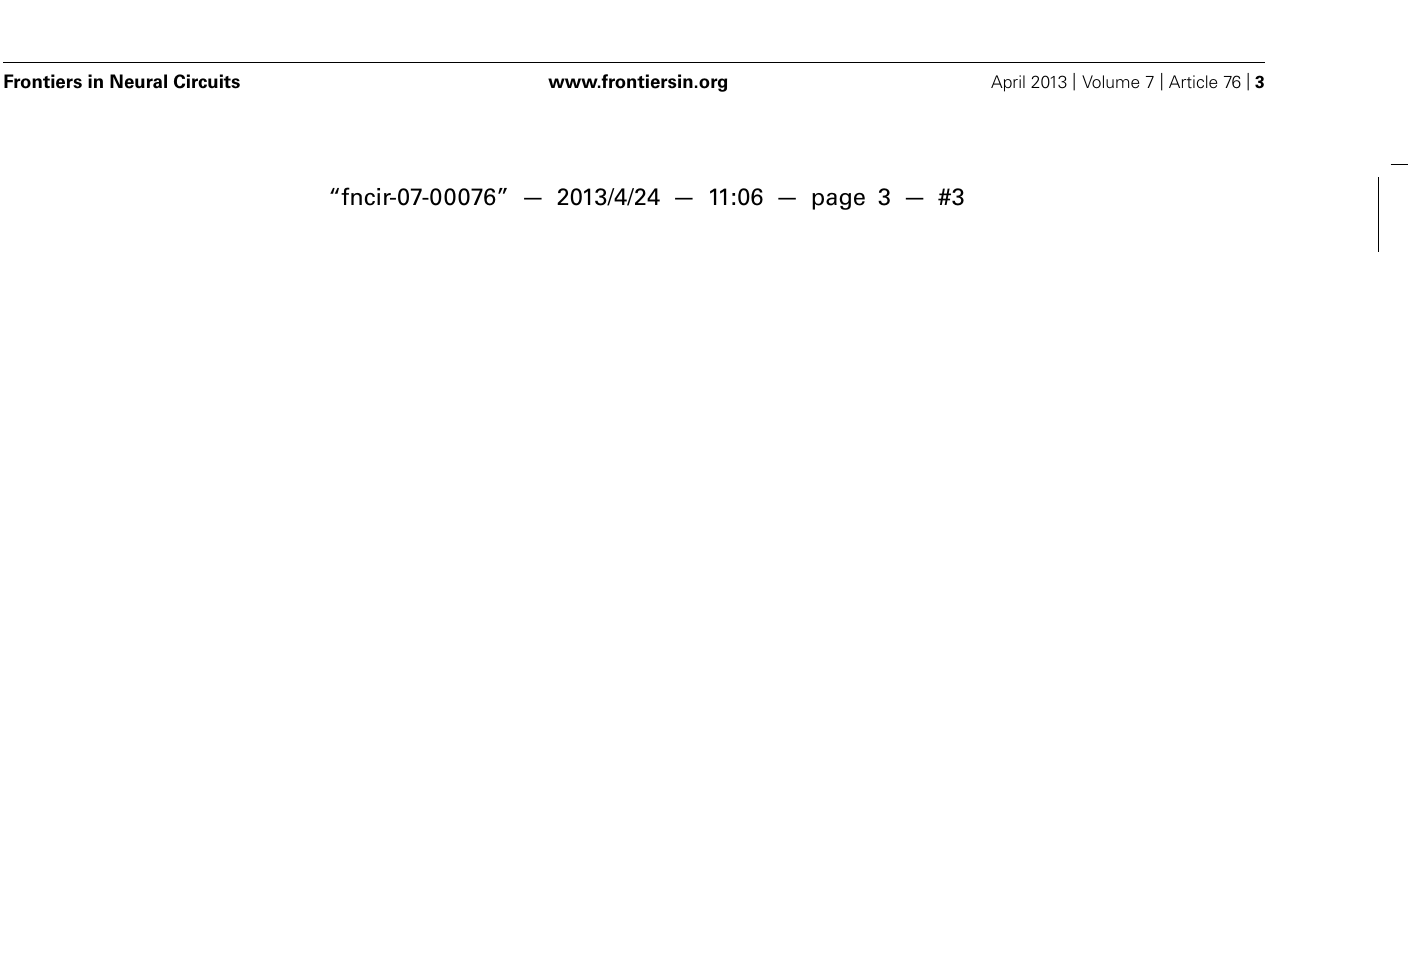
FIGURE 2 | Roadmap of the steps a zebrafish neuroscience researcher can take to integrate the various levels of analysis within the same model organism. GECI, Genetically encoded calcium indicator; AT, ArrayTomography; tol2,Tol2 transposase; SyGCaMP, Synaptophysin-specific GCaMP sensor.